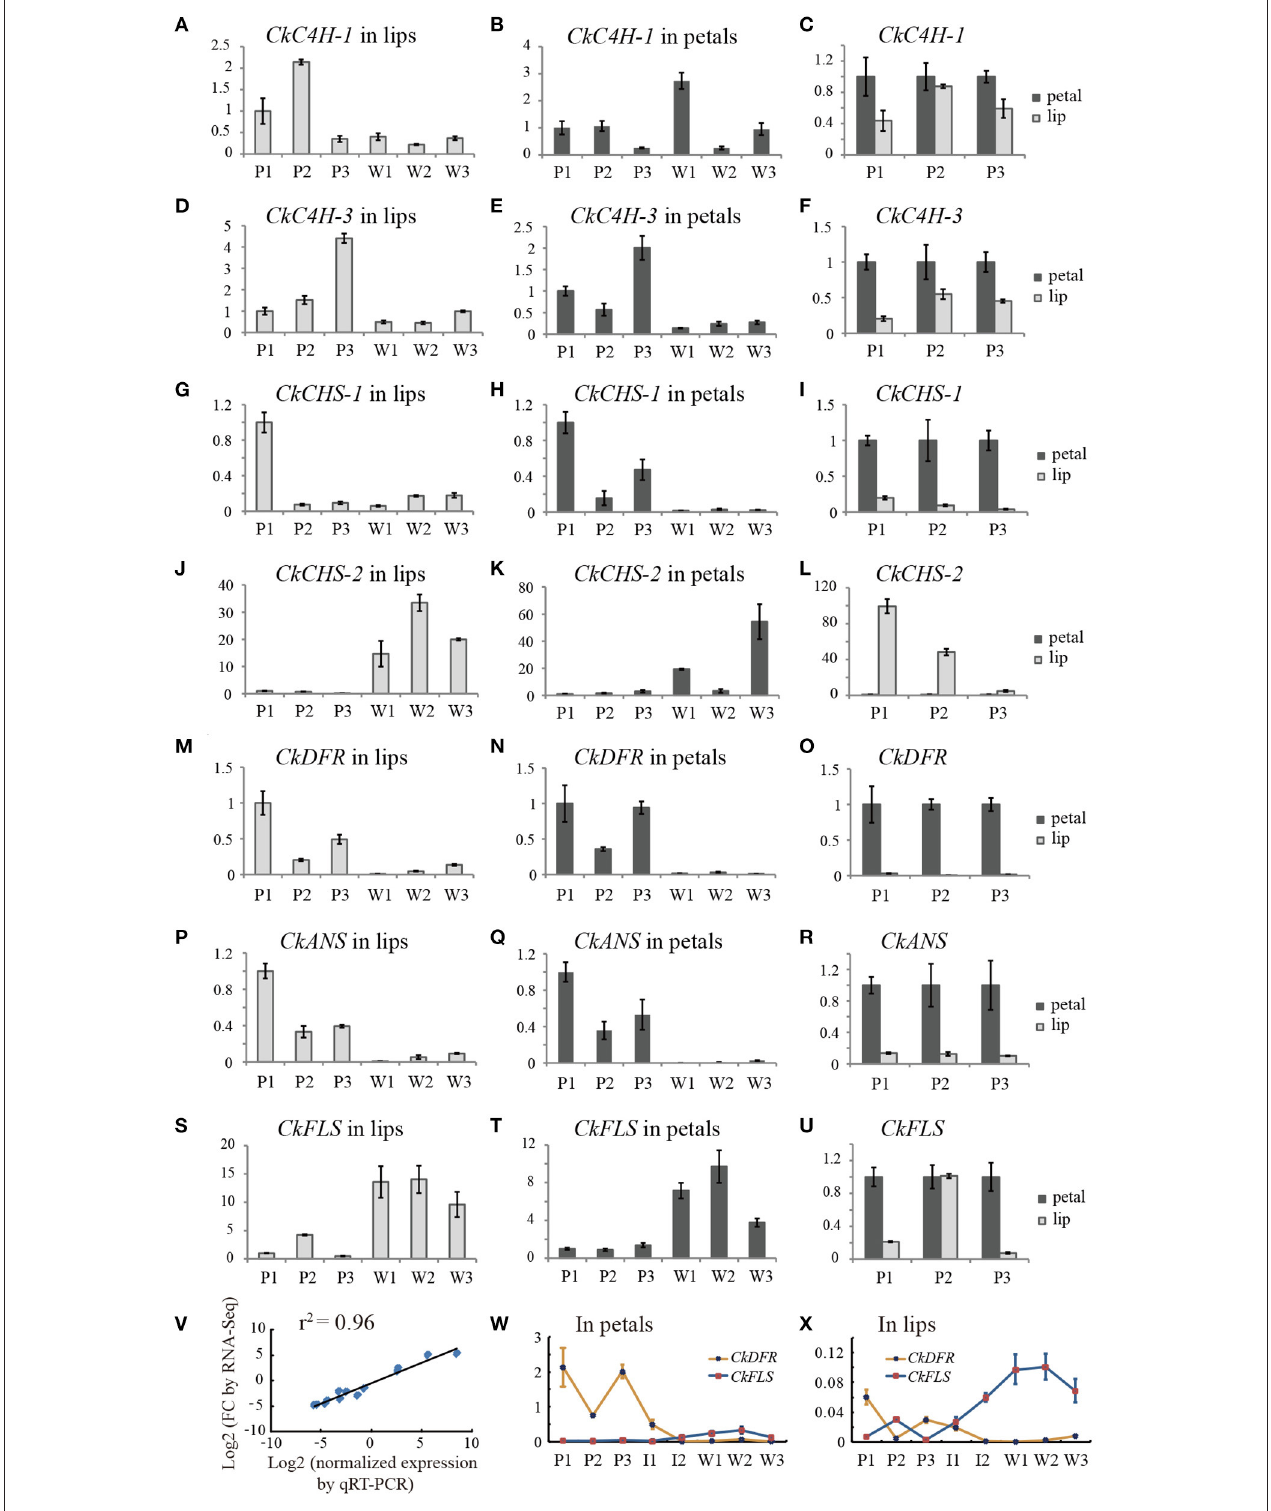
FIGURE 5 | Transcript accumulation measurements of colour-related genes involved in the anthocyanidin metabolic process. (A–U) The qRT-PCR analysis of differentially expressed genes from RNA-Seq analysis. (V) Correlation of gene expression results obtained by qRT-PCR analysis and RNA-Seq for colour-related genes of the purple-red and white flower buds (length of approximately 3.0cm). (W,X) line charts of the relative expression levels of DFR and FLS in petals and lips, respectively. The Y-axis of all charts except V represents the relative expression level. P1, purple-red C. kanran 1; W1, white C. kanran 1; I1, intermediate phenotype C. kanran